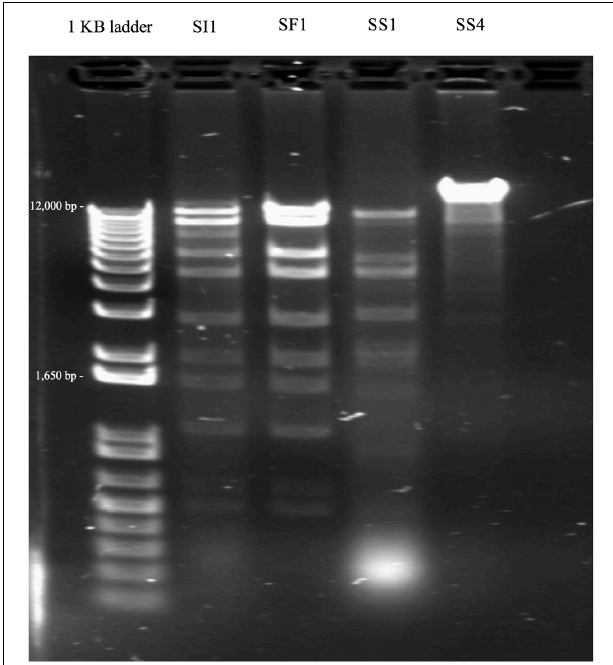
FIGURE 2 | Restriction banding patterns of phage upon digestion by endonuclease EcoR